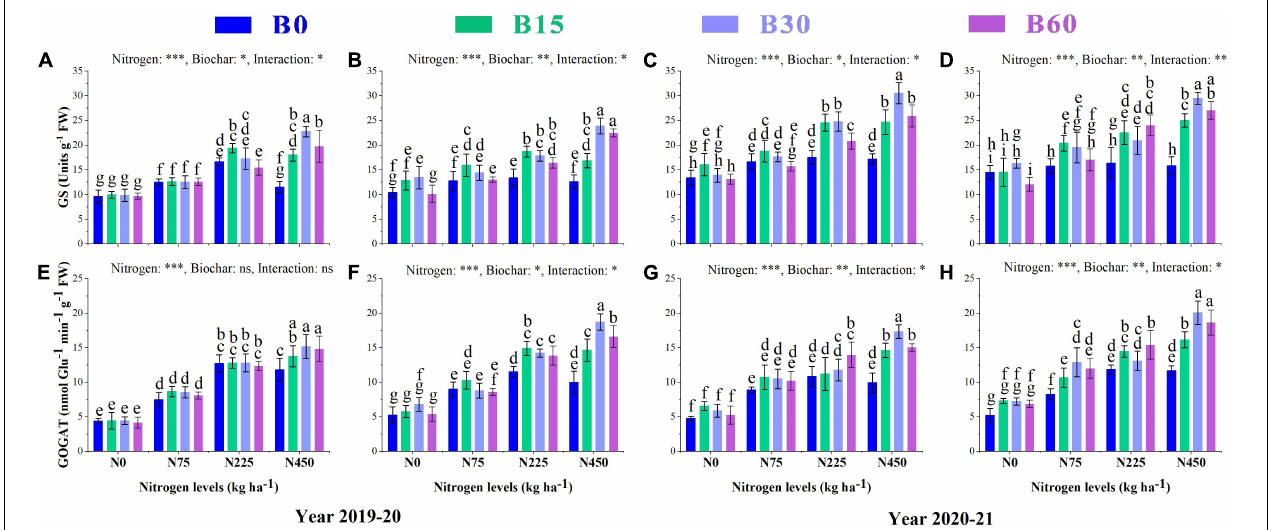
FIGURE 3 | Integral effects of biochar and nitrogen on glutamate synthase GS (A) SS and (B) FS in 2019–2020 and (C) SS and (D) FS in 2020–2021 and glutamine synthetaseGOGAT (E) SS and (F) FS in 2019–2020 and (G) SS and (H) FS in 2020–2021. SS: seedling stage, FS: flowering stage. B0: 0 t ha − 1 biochar; B15: 15 t ha − 1 biochar; B30: 30 t ha − 1 biochar; B60: 60 t ha − 1 biochar; N0: 0 kg ha − 1 nitrogen; N75: 75 kg ha − 1 nitrogen; N225: 225 kg ha − 1 nitrogen, and N450: 450 kg ha − 1 nitrogen, error bars represent standard error for each treatment in three replicates. Different letters on each bar represent significant differences according to the LSD test ( p <